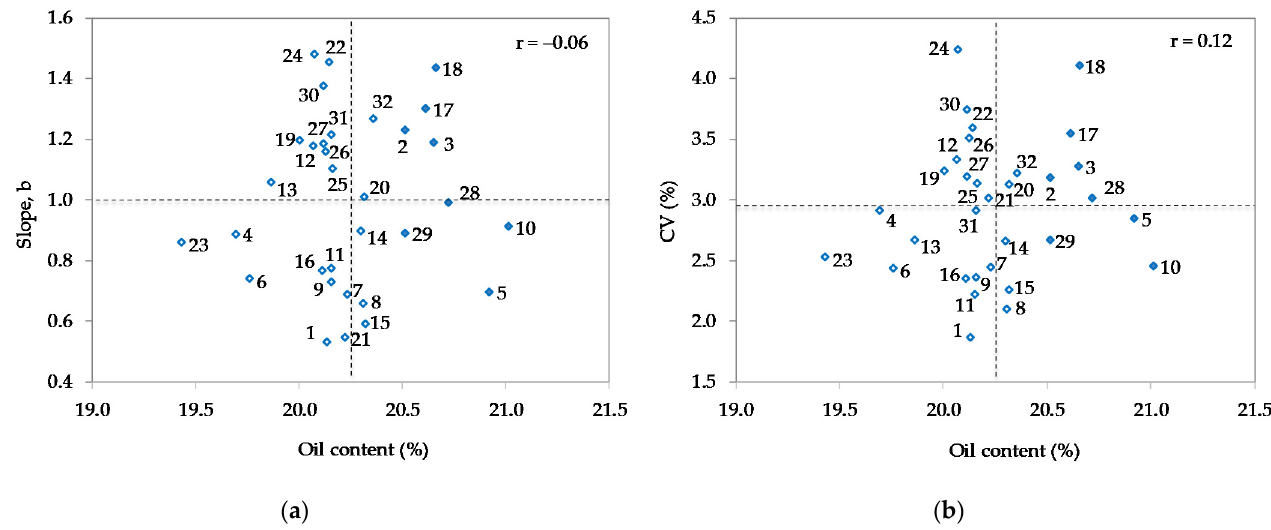
Figure 5. Biplot of mean oil content of 32 soybean genotypes and their respective slope, b from the regression analysis ( a ) and mean protein content of 32 soybean genotypes and their respective coefficient of variation (CV) ( b ). Vertical and horizontal dashed lines represent means across genotypes for oil content and corresponding stability coefficient (b or CV), respectively. The top eight genotypes (with oil content in the first quartile) were shown as filled rectangles.